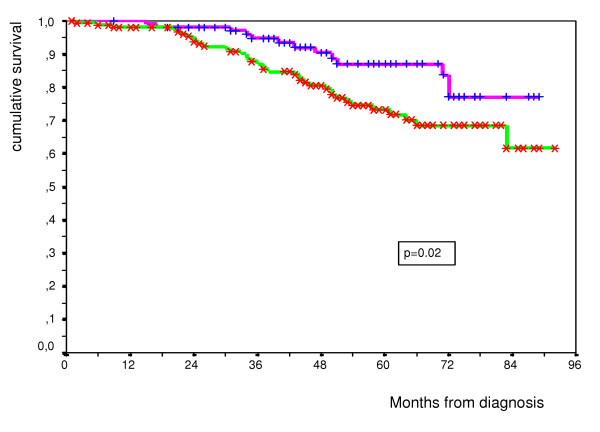
5-year survival in N+ BC. 5-year OS values of N+ breast cancers between MSP participants and non-participants were equal to 87% and 73% respectively (Log Rank = 5.02). [ = MSP participants;  = MSP non-participants]